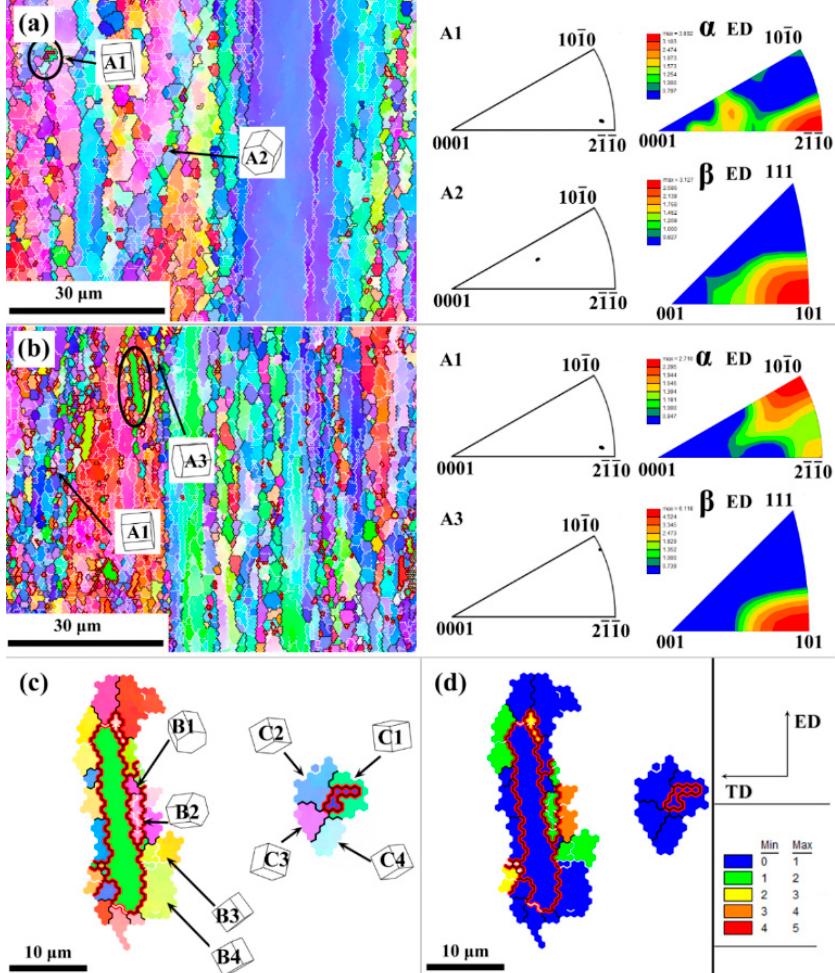
Figure 3. ( a ) IPF mapping, discrete plot and texture of alloy extruded at 800 °C; ( b ) IPF mapping, discrete plot and texture along extrusion direction (ED) of composite extruded at 800 °C; ( c ) highlighted mapping of ( a , b ); ( d ) grain orientation spread (GOS) mapping of ( c ).